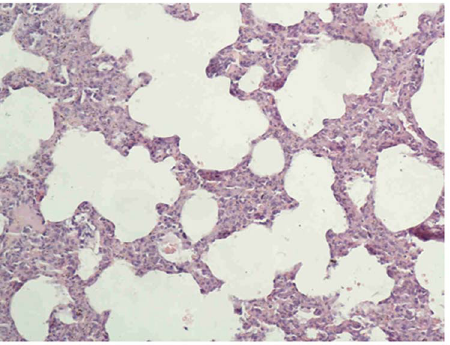
Figure 5. HE stain of bosentan group ( 6 200). The damage is improved more than that of the PQ group, and less inflammatory cell infiltration were found in the interstitial lung and alveoli, interstitial edema and alveolar hemorrhage were ameliorated.